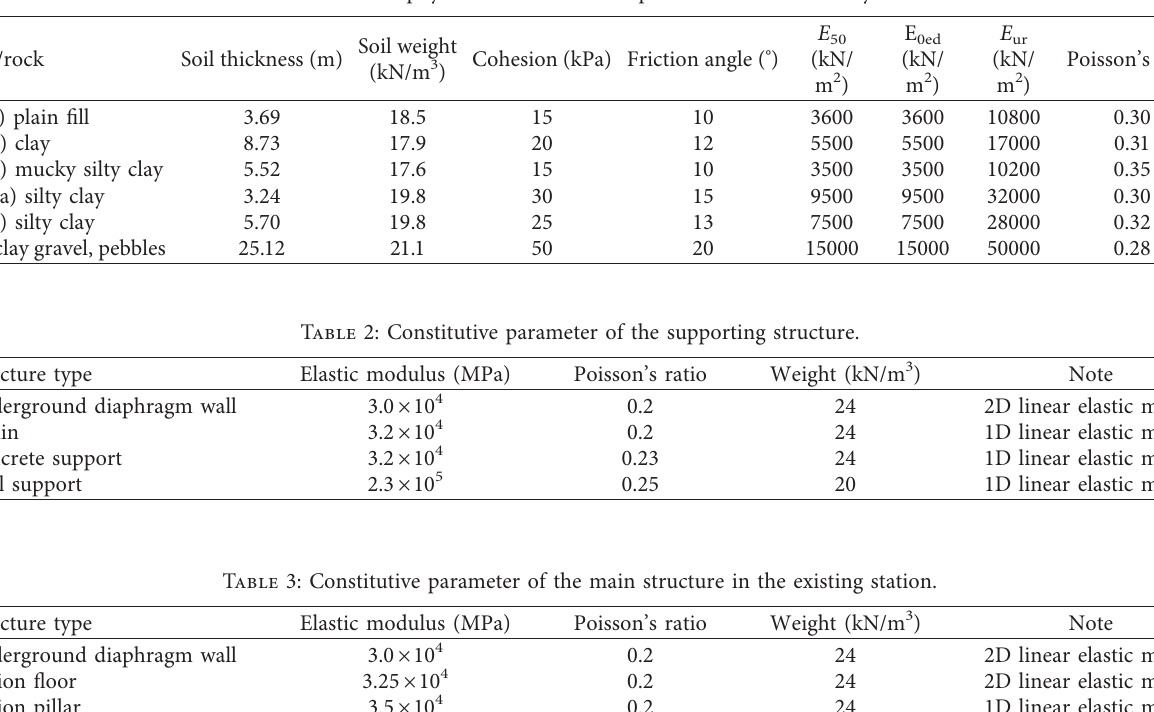
Figure 2: Numerical simulation model. Table 1: Main physical and mechanical parameters of the soil layer.